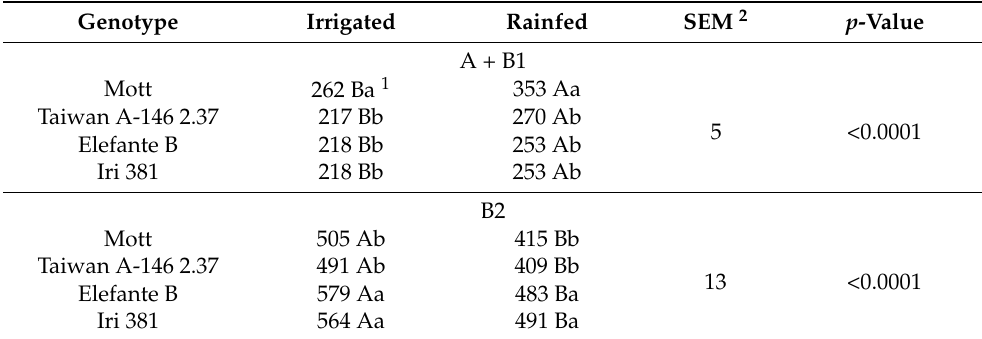
Table 12. Stem carbohydrate fractions A + B1 and B2 (g/kg carbohydrate) as affected by the interac- tion between genotype and irrigation for elephantgrass genotypes at Garanhuns, Pernambuco, Brazil.